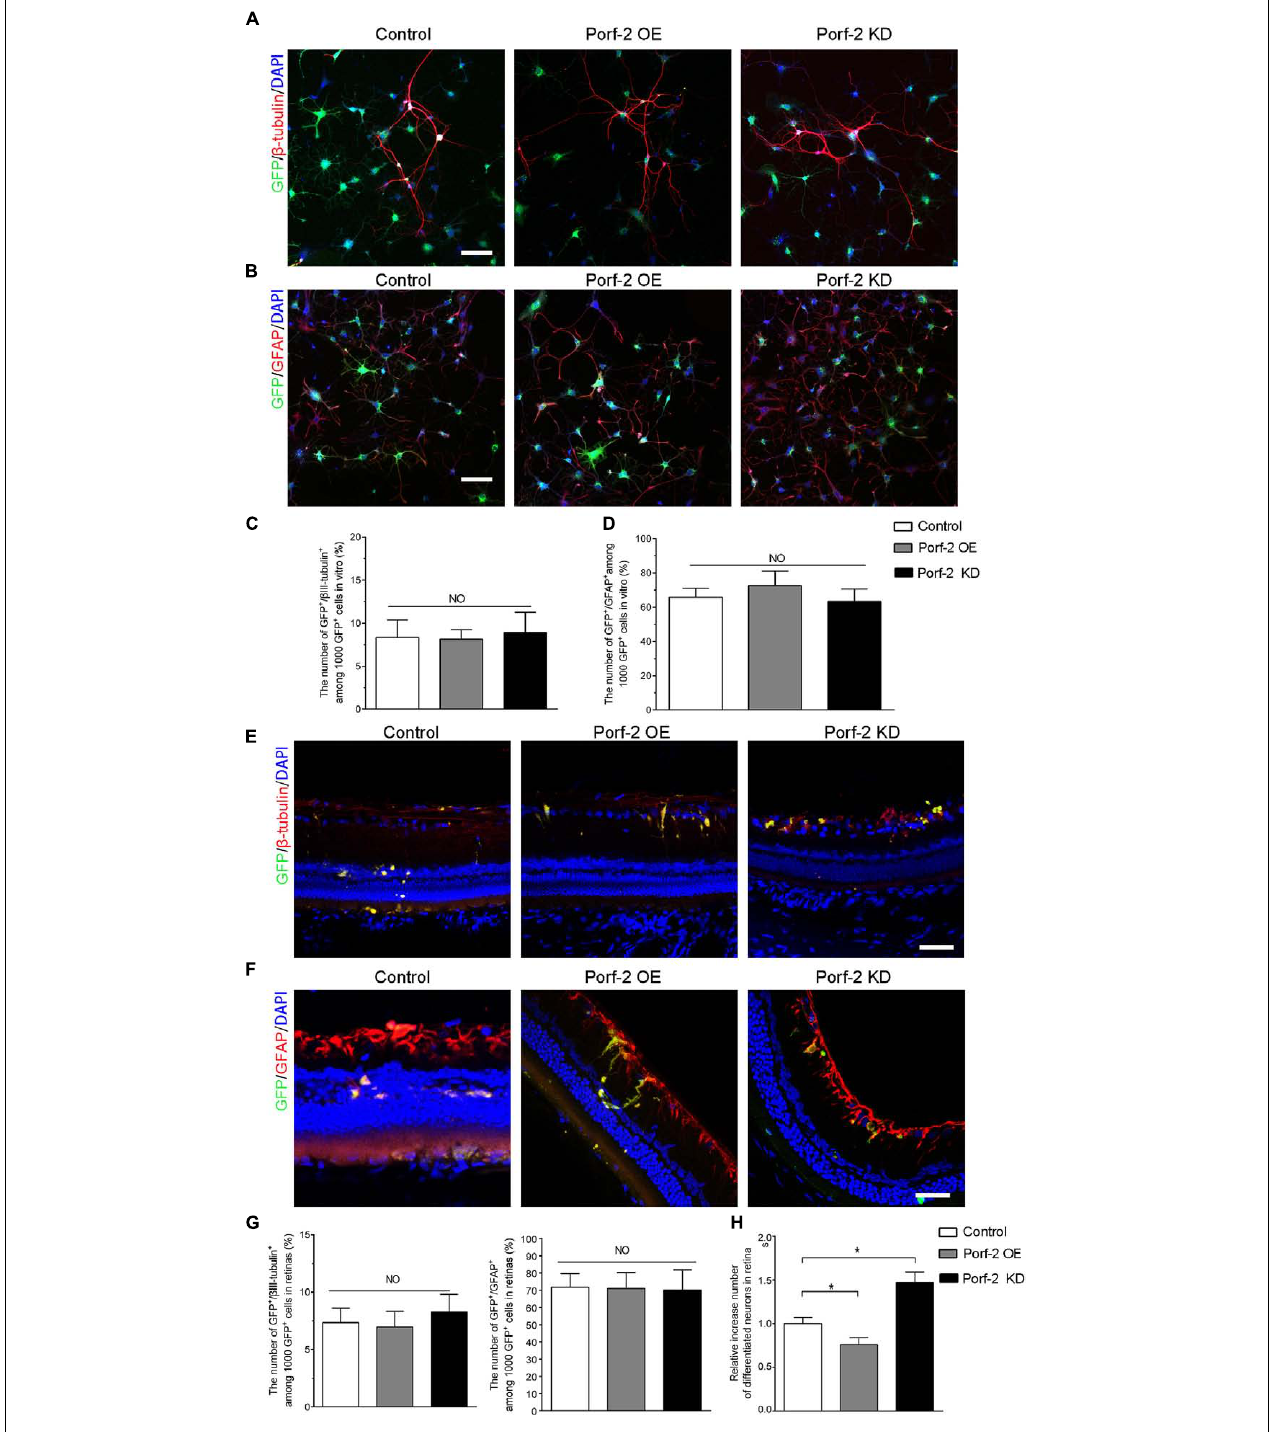
FIGURE 6 | Effect of Porf-2 knockdown or overexpression on the neuronal and astrocytic differentiation of NSCs in vitro and in vivo . (A,B) Immunocytochemical analysis of Porf-2 knockdown and Porf-2-overexpression NSCs in vitro . Expression of β -tubulin III or GFAP in Porf-2 knockdown cells and Porf-2-overexpression cells after the induction of differentiation by serum starvation. Scale bars: 100 µ m. (C,D) The percentage of β -tubulin III or GFAP double-positive cells was calculated. (E,F) Immunocytochemical analysis of Porf-2 knockdown and Porf-2-overexpression NSCs in vivo ( n = 6 rats). Expression of β -tubulin III or GFAP in Porf-2 knockdown cells and Porf-2-overexpression cells at 10 weeks post-transplantation. Scale bars: 50 µ m. (G) The percentage of β -tubulin III or GFAP double-positive cells was calculated. (H) Comparison the number of differentiated neurons in Control, Porf-2 KD and Porf-2 OE groups at 10 week after transplantation ( n = 6). The data was normalized to Control group. ∗ p < 0.05. Error bars indicate the SD of the mean.